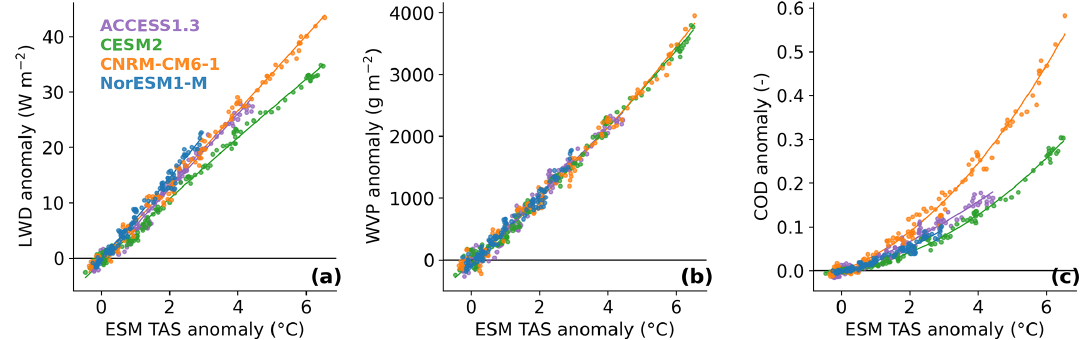
Figure 3. Changes in downwelling longwave fluxes (Wm − 2 ) (a) , water vapour path (gm − 2 ) (b) , and cloud optical depth (–) (c) as projected by MAR forced by ACCES1.3 (purple), CESM2 (green), CNRM-CM6-1 (orange), and NorESM1-M (blue) over the ice shelves of the West Antarctic sector compared to mean summer ESM near-surface temperature ( ◦ C) over 90–60 ◦